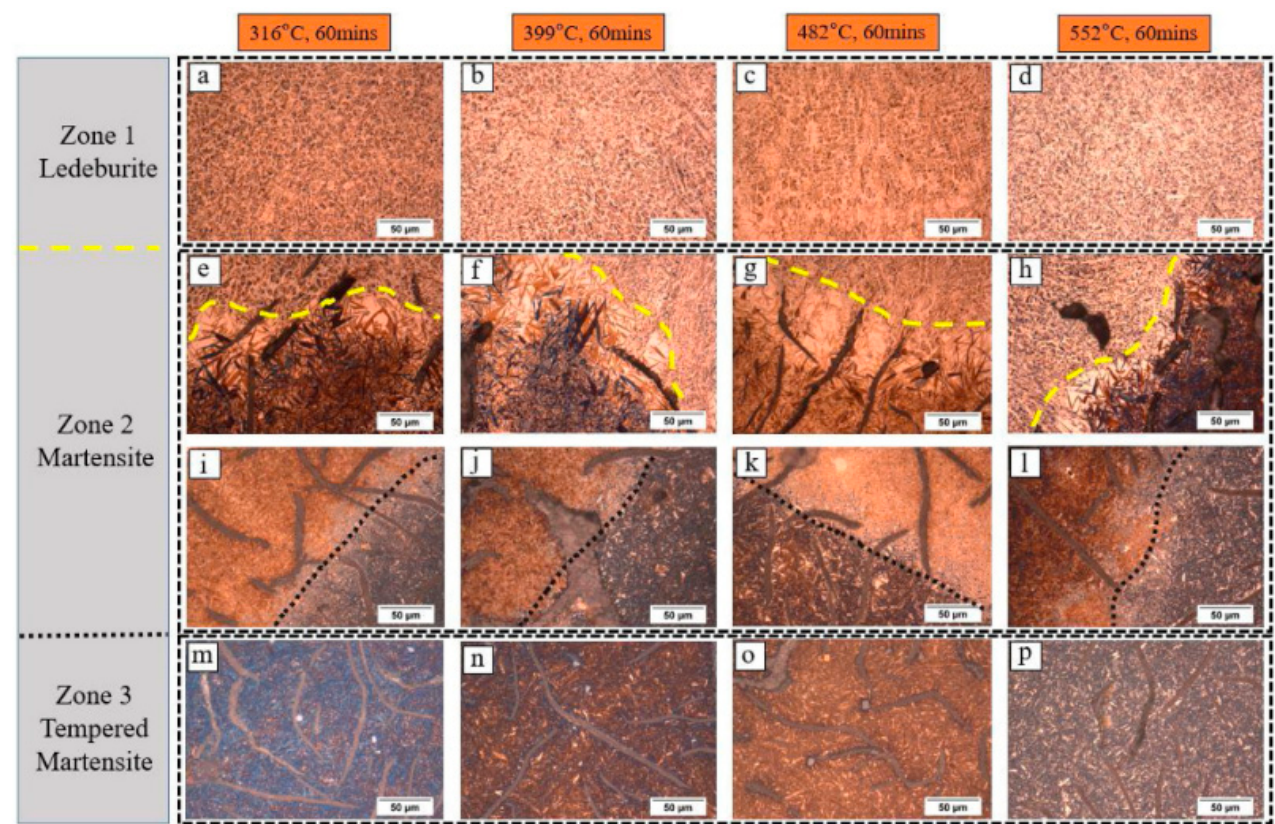
Figure 3. Microstructure of LHQTGI with different tempering temperatures: (a) laser hardened zone (Zone 1) at 316 °C, (b) Zone 1 at 399 °C, (c) Zone 1 at 482 °C, (d) Zone 1 at 552 °C, (e) interface between Zone 1 and Zone 2 (heat-affected zone) at 316 °C, (f) interface between Zone 1 and Zone 2 at 399 °C, (g) interface between Zone 1 and Zone 2 at 482 °C, (h) interface between Zone 1 and Zone 2 at 552 °C, (i) interface between Zone 2 and Zone 3 (substrate) at 316 °C, (j) interface between Zone 2 and Zone 3 at 399 °C, (k) interface between Zone 2 and Zone 3 at 482 °C, (l) interface between Zone 2 and Zone 3 at 552 °C, (m) Zone 3 at 316 °C, (n) Zone 3 at 399 °C, (o) Zone 3 at 482 °C, (p) Zone 3 at 552 °C (Reprinted with permission from ref. [43]. 2020 Elsevier).